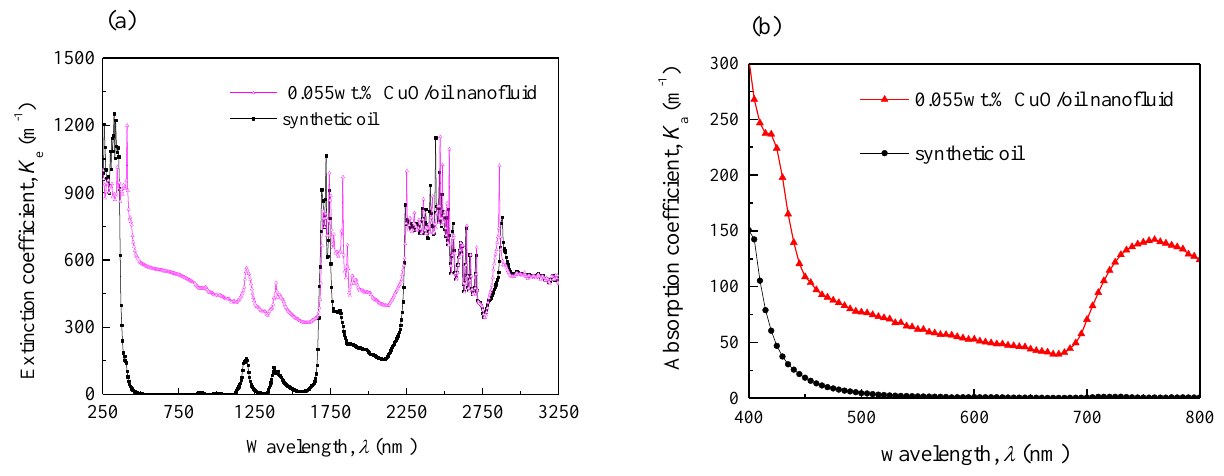
Figure 5. Extinction and absorption spectra of CuO/oil nanofluid and pure synthetic oil. ( a ) Variations of extinction coefficient with wavelength; ( b ) Variations of absorption coefficient with